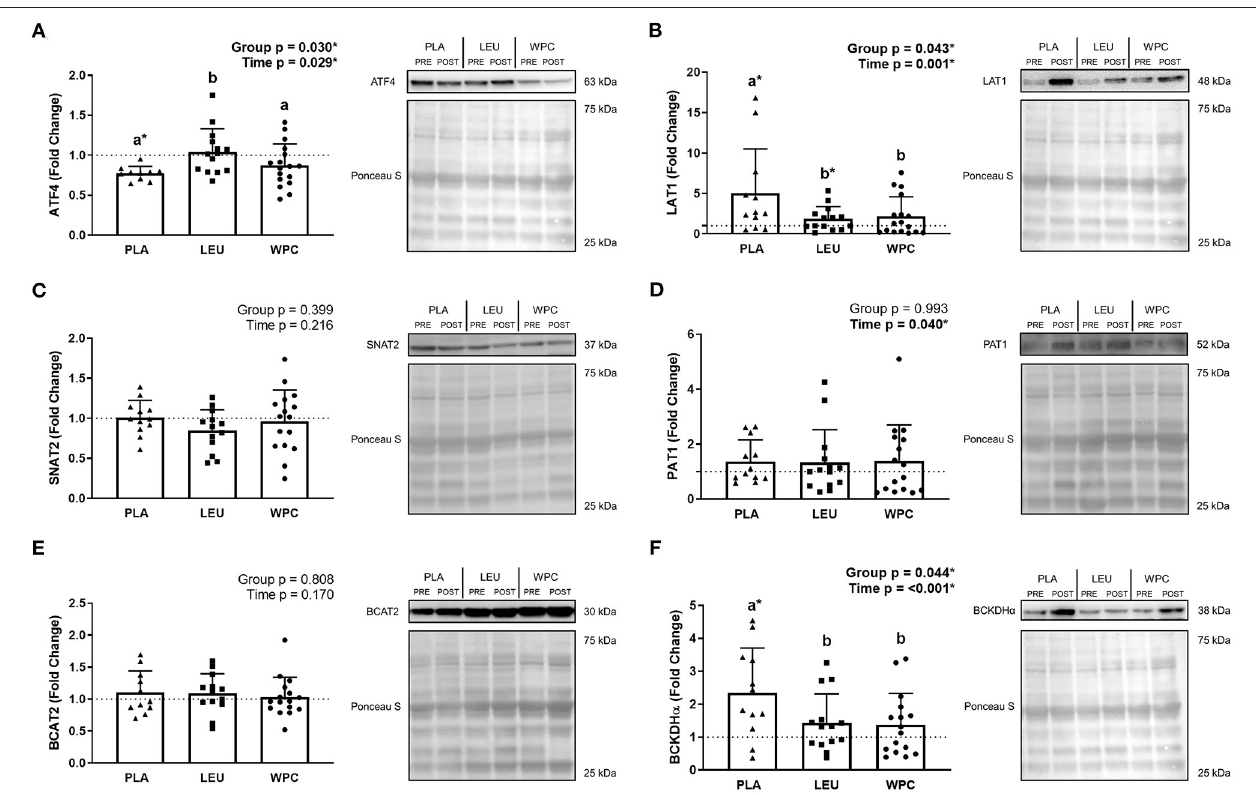
FIGURE 2 | The protein content of amino acid transporters and metabolic enzymes are altered following 12 weeks of resistance exercise training. The fold change from PRE, designated as the dashed line at 1.00, for ATF4 (A) , LAT1 (B) , SNAT2 (C) , PAT1 (D) , BCAT2 (E) , and BCKDH α (F) protein content for each group. A representative image for each protein and loading control (i.e., Ponceau S stain) accompanies each panel. Differing letters represent significant differences between groups within each time point. * p < 0.050 compared to PRE within group only if the G × T interaction was significant. Data are represented as mean ± standard deviation. Sample size for each group is PLA = 10–12, LEU = 13–14, and WPC =